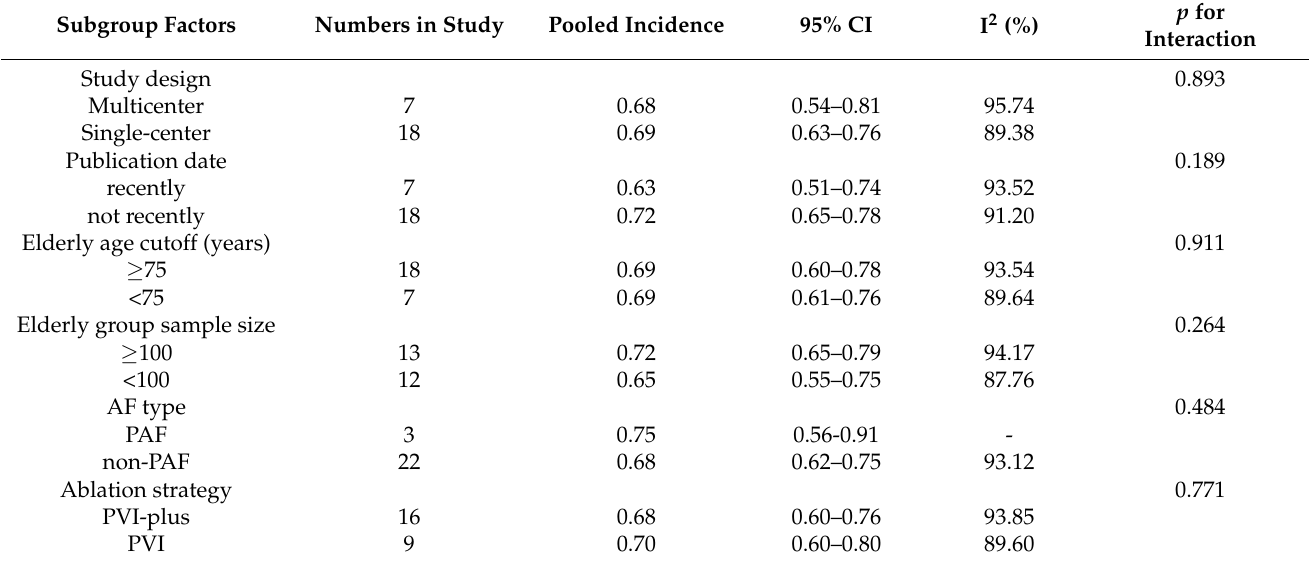
Table 2. Subgroup analysis of the rate of freedom from atrial fibrillation in the elderly group.